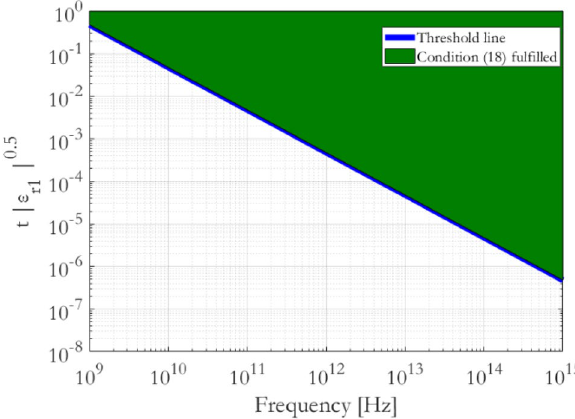
Figure 4. Design space for ENG metaconductive surfaces ( ε r 1 < 0 and µ r 1 = 1 ) according to Eq. (18). Analogous design space can be plotted for MNG metamaterials ( µ r 1 < 0 and ε r 1 = 1